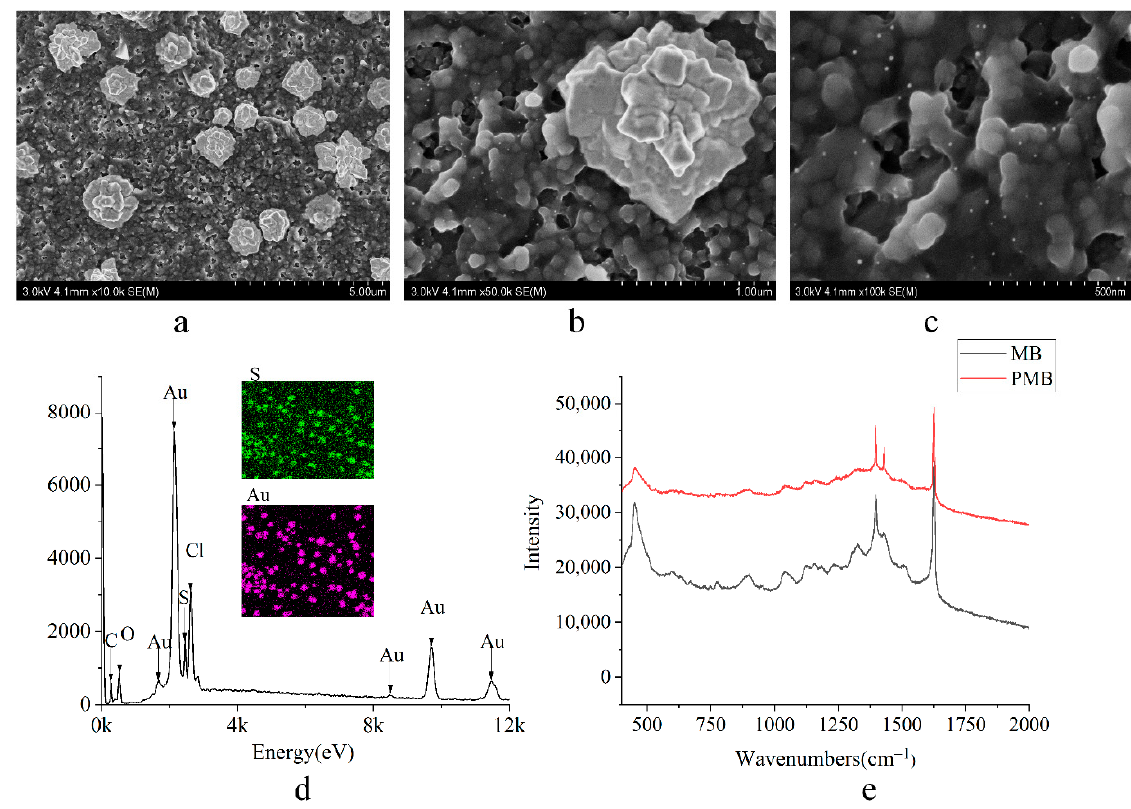
Figure 5. SEM images (( a ) × 10 K, ( b ) × 50 K, ( c ) × 100 K), energy-dispersive X-ray spectroscopy ( d ) and Raman spectroscopy ( e ) of SEPC/AuNPs/PMB electrode.